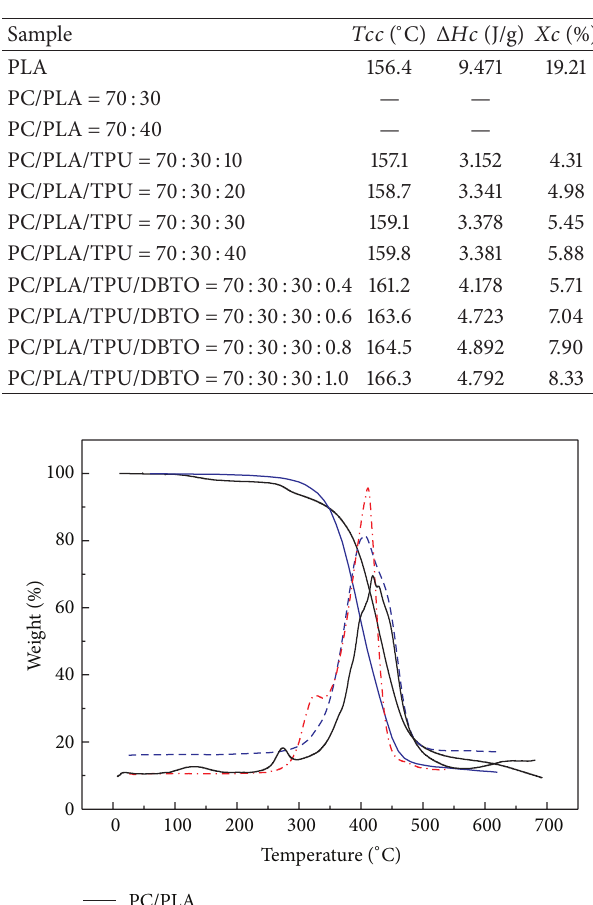
Table 1: DSC data of PLA and PLA composites.